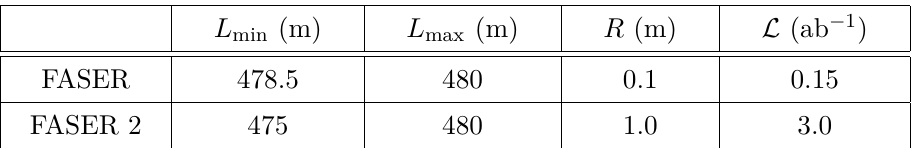
Table 1 . Dimensions of the FASER and the FASER2 detector and the integrated luminosity L used in this study. Here, L min and L max are the distances between IP and the front and the rear of the detector, respectively, and R is the radius of the